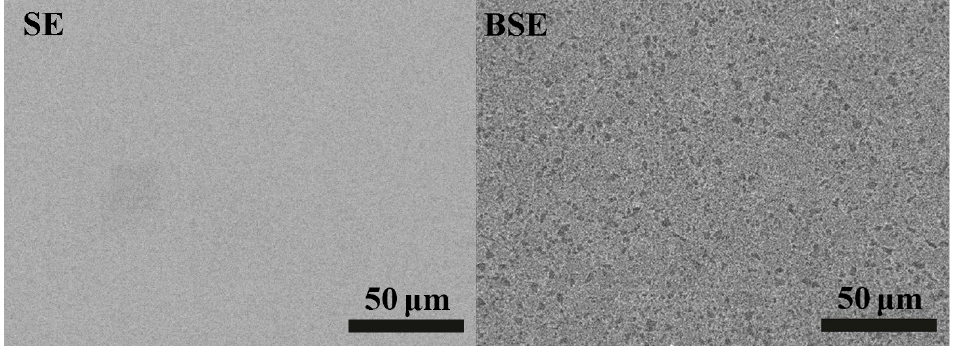
Figure 3. SEM morphology of the as-HIPed Ni3#